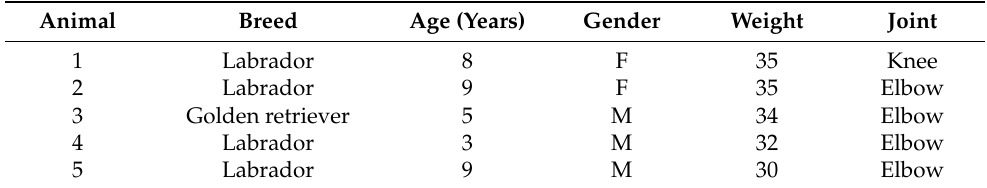
Table 1. Summary of cases included in this study regarding the breed, age, gender, weight and affected joint.